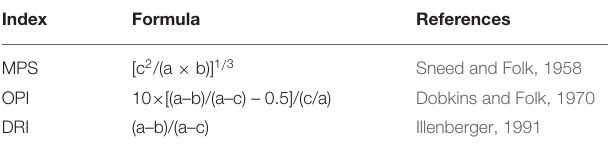
TABLE 1 | Calculation methods of boulder shape